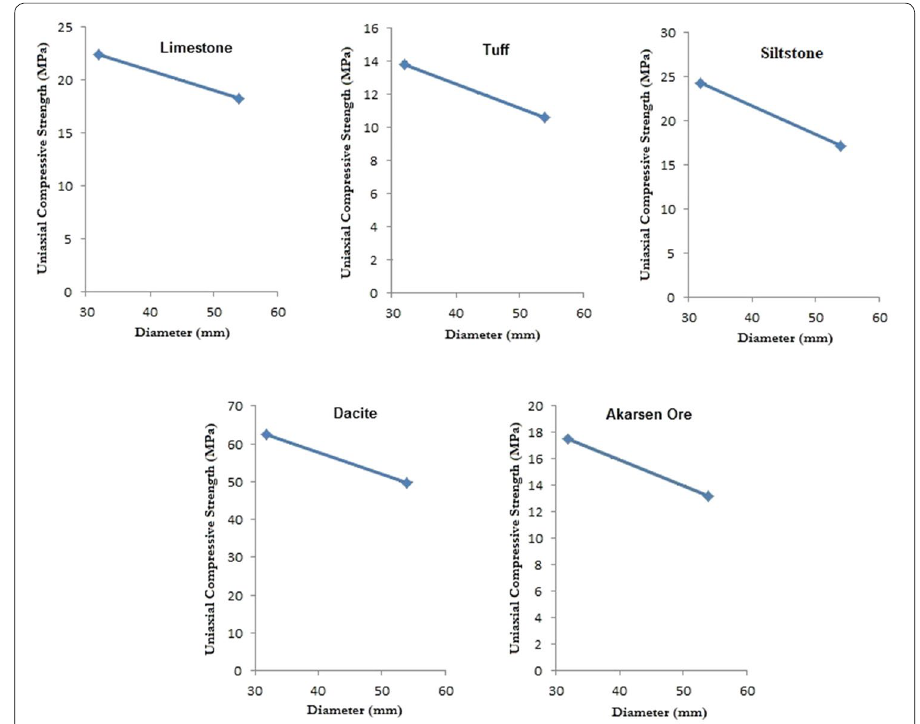
Fig. 6 UCS values under same load rate (kN/s)